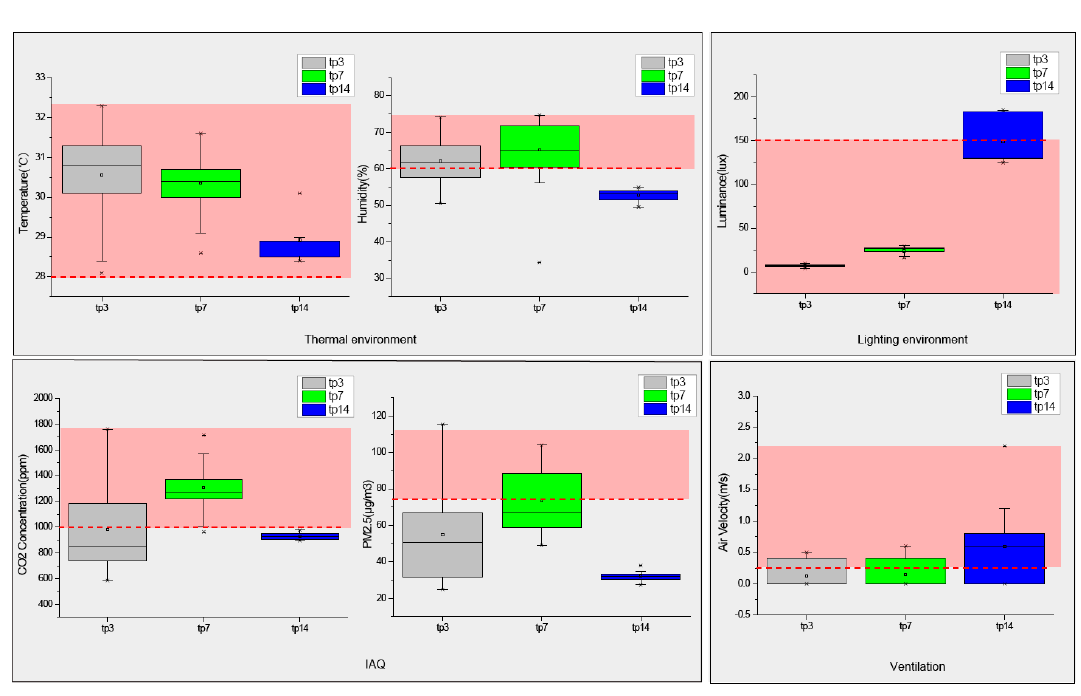
Table 7. Average values for the physical test results from the tube entrance (connection to subway).